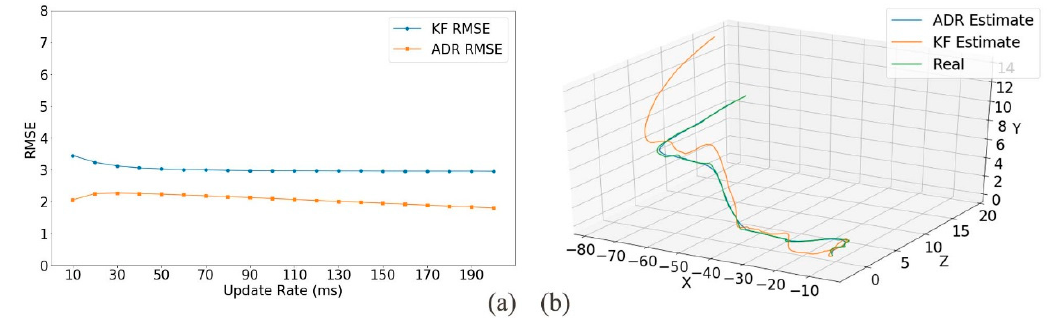
Figure 7. Comparison between adjusted dead reckoning (ADR) and the Kalman filter (KF): ( a ) accuracy of the two algorithms and ( b ) real prediction results.